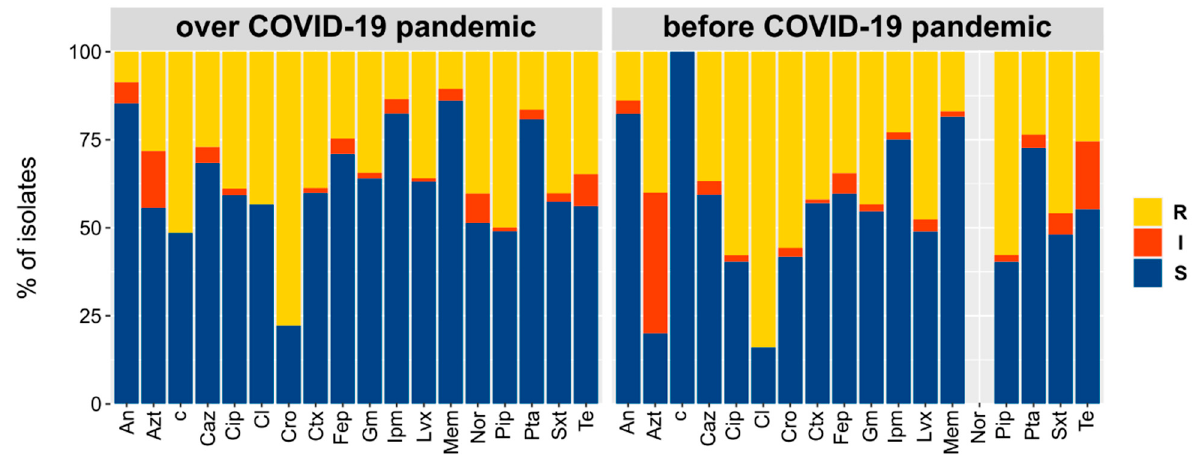
Figure 4. Percentages of strains, isolated during ( left ) and before ( right ) the COVID-19 pandemic, resistant to the tested antibiotics. An = amikacin, Azt = aztreonam, Fep = cefepime, Ctx = cefotaxime, Caz = ceftazidime, Cro = ceftriaxone, Ipm = imipenem, Lvx = levofloxacin, Mem = meropenem, Nor = norfloxacin, Pip = piperacillin, Pta = piperacillin-tazobactam, Te = tetracycline, Sxt = trimethoprim/sulfamethoxazole, Gm = gentamicin, Cl = colistin, Cip = ciprofloxacin, c = chloramphenicol. The test aimed at evaluating susceptibility to norfloxacin was introduced after gathering data relative to “before COVID-19 pandemic”.